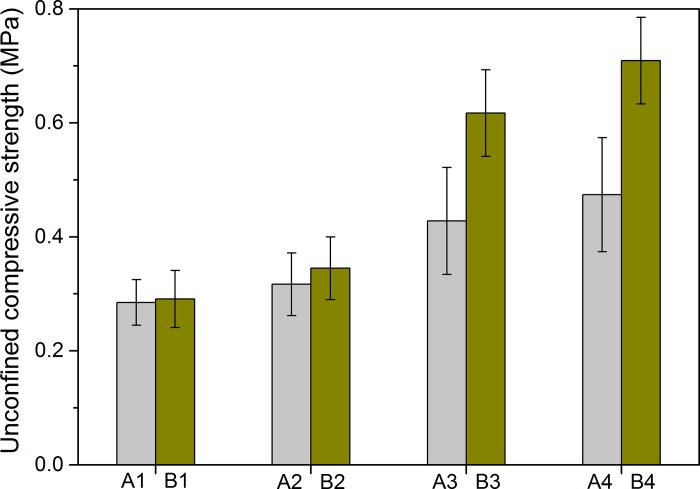
UCS of the treated MSWI fly ashes.